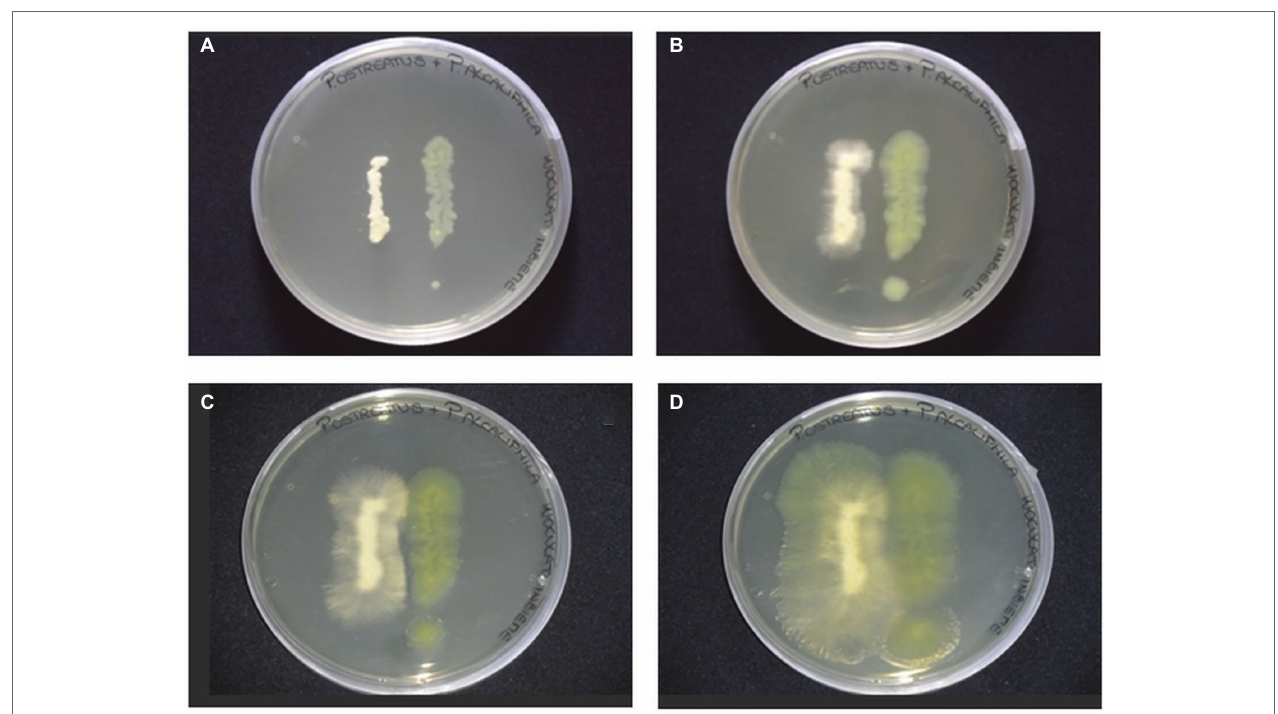
FIGURE 1 | Plate inhibition assays of P. ostreatus (left side) and P. alcaliphila (right side) grown on Luria Bertani agar (1.5%) for 24 (A) , 48 (B) , 72 (C) , and 120 (D) h at 30 ° C in the